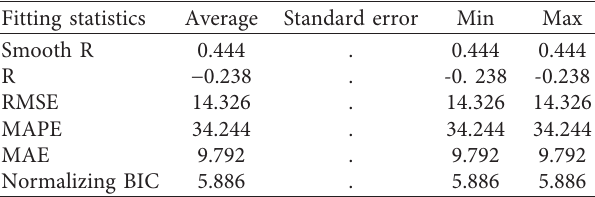
Table 1: ARIMA model-fitting degree.